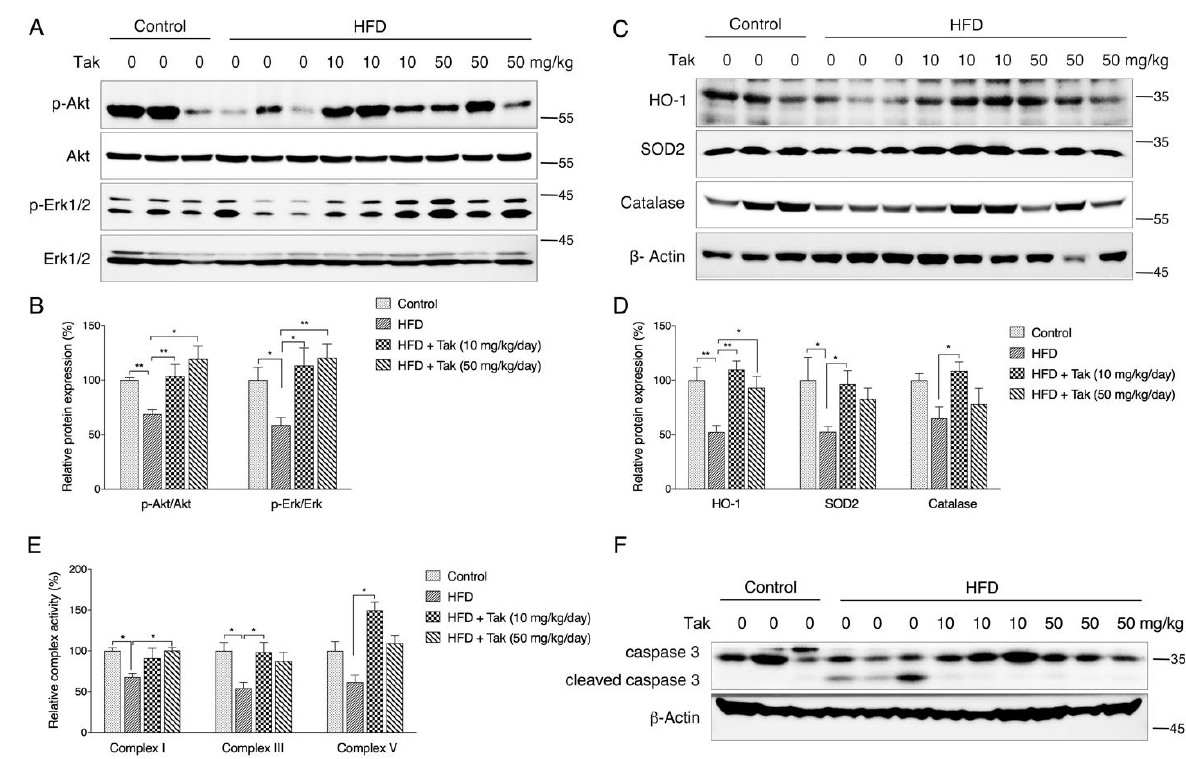
Figure 7. The effects of Tak on hippocampal neurons. Mice were fed a chow diet or HFD with or without Tak supplementation at doses of 10 and 50 mg/kg/day for 8 weeks, and the hippocampus tissues was collected for analysis. p-Akt and p-Erk were analyzed by western blot (( A ): western blot images; ( B ): statistical analysis). HO-1, SOD2, and catalase were analyzed by western blot (( C ): western blot images; ( D ): statistical analysis). ( E ) Mitochondrial complex activities. ( F ) Caspase cleavage was analyzed by western blot. The values are presented as the mean ± S.E.M. ( n = 8). * p < 0.05 and ** p < 0.01 between the connected groups.